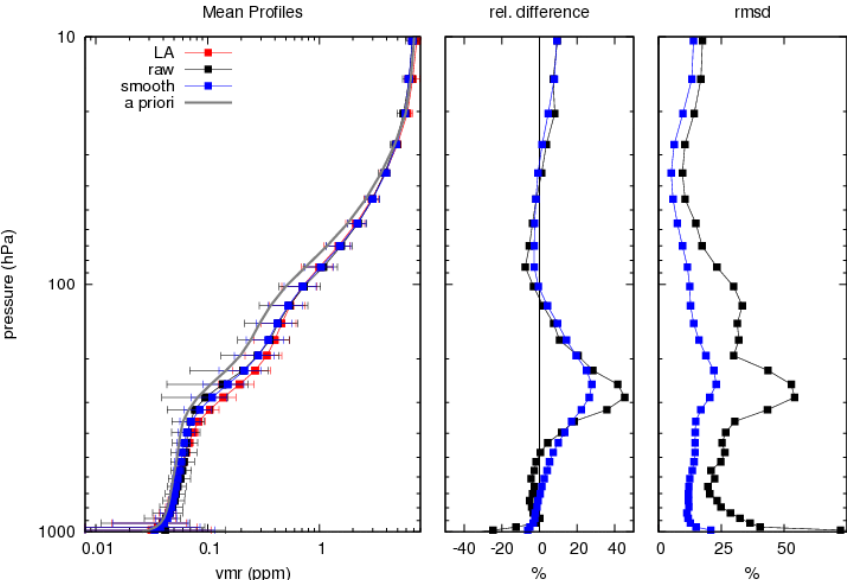
distribution for the LA, LATMOS/ULB and LISA products are presented in the top, middle and bottom panels, respectively.